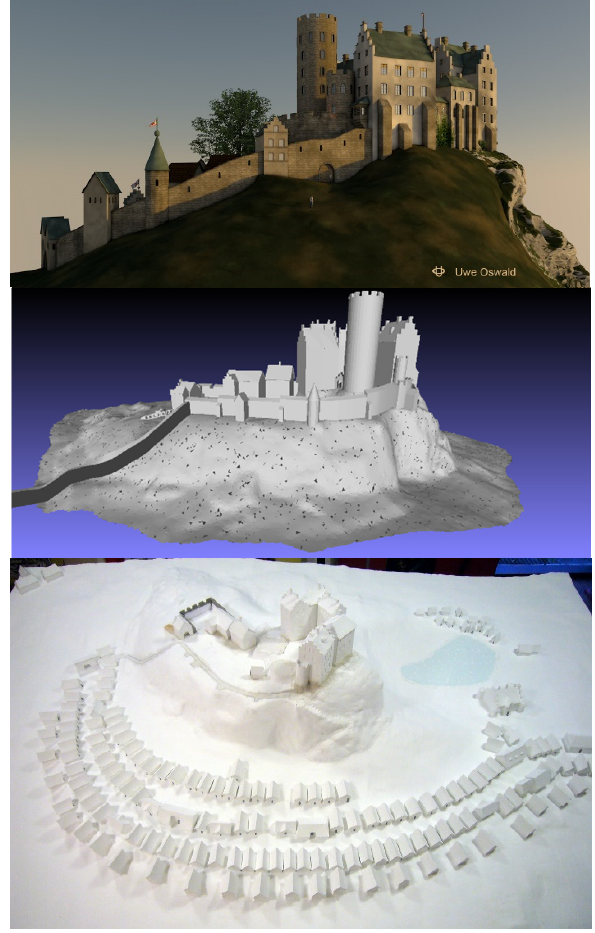
Figure 4. The first virtual 3D model of the Kalkberg and the Siegesburg (top), the second revised version (centre) both created by Dipl.-Ing. Uwe Oswald in Cinema 4D, and the final physical castle model in the museum exhibition (bottom)